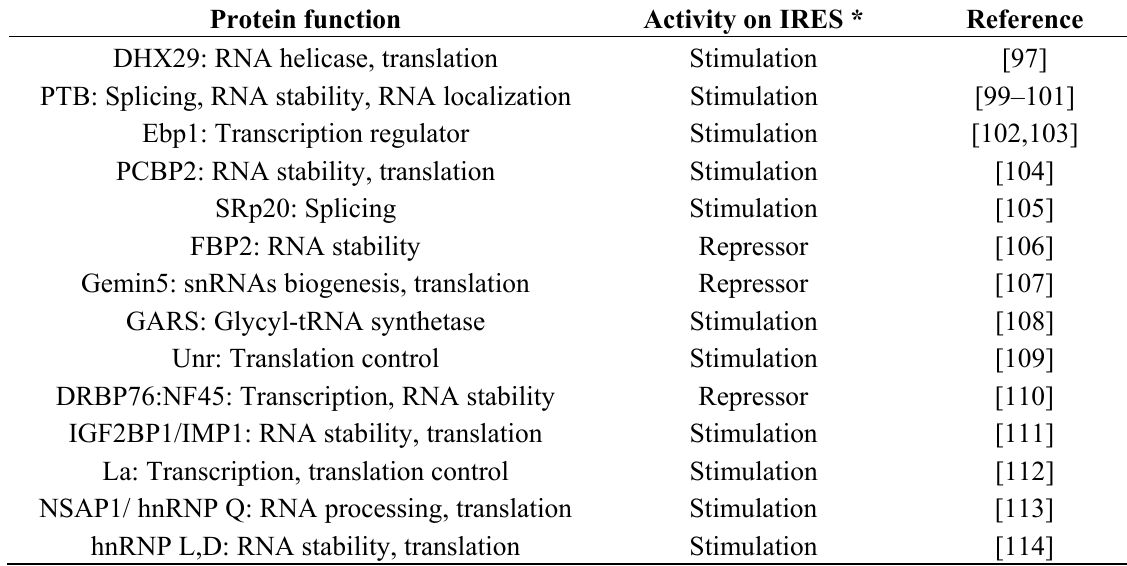
Table 2. RNA-binding proteins modulating viral IRES